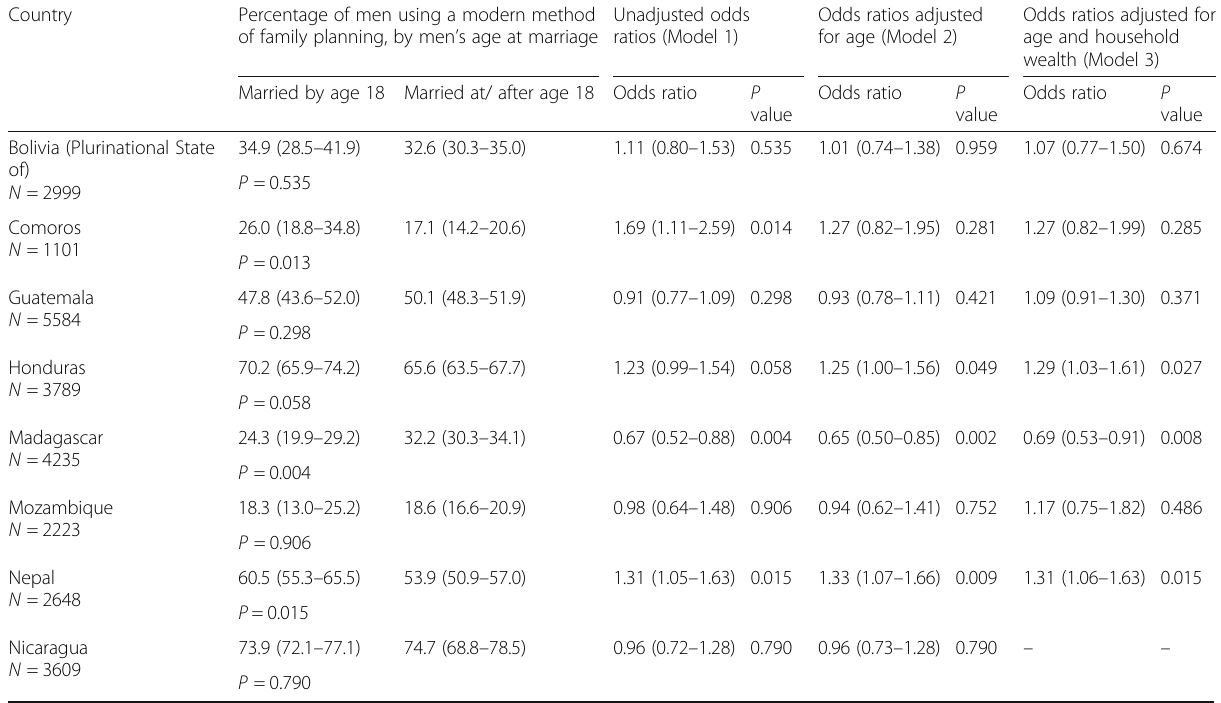
Table 4 The odds of using a modern method of family planning, comparing men currently aged 20 – 49 who were married by age 18 with those married at or after 18 (reference group)